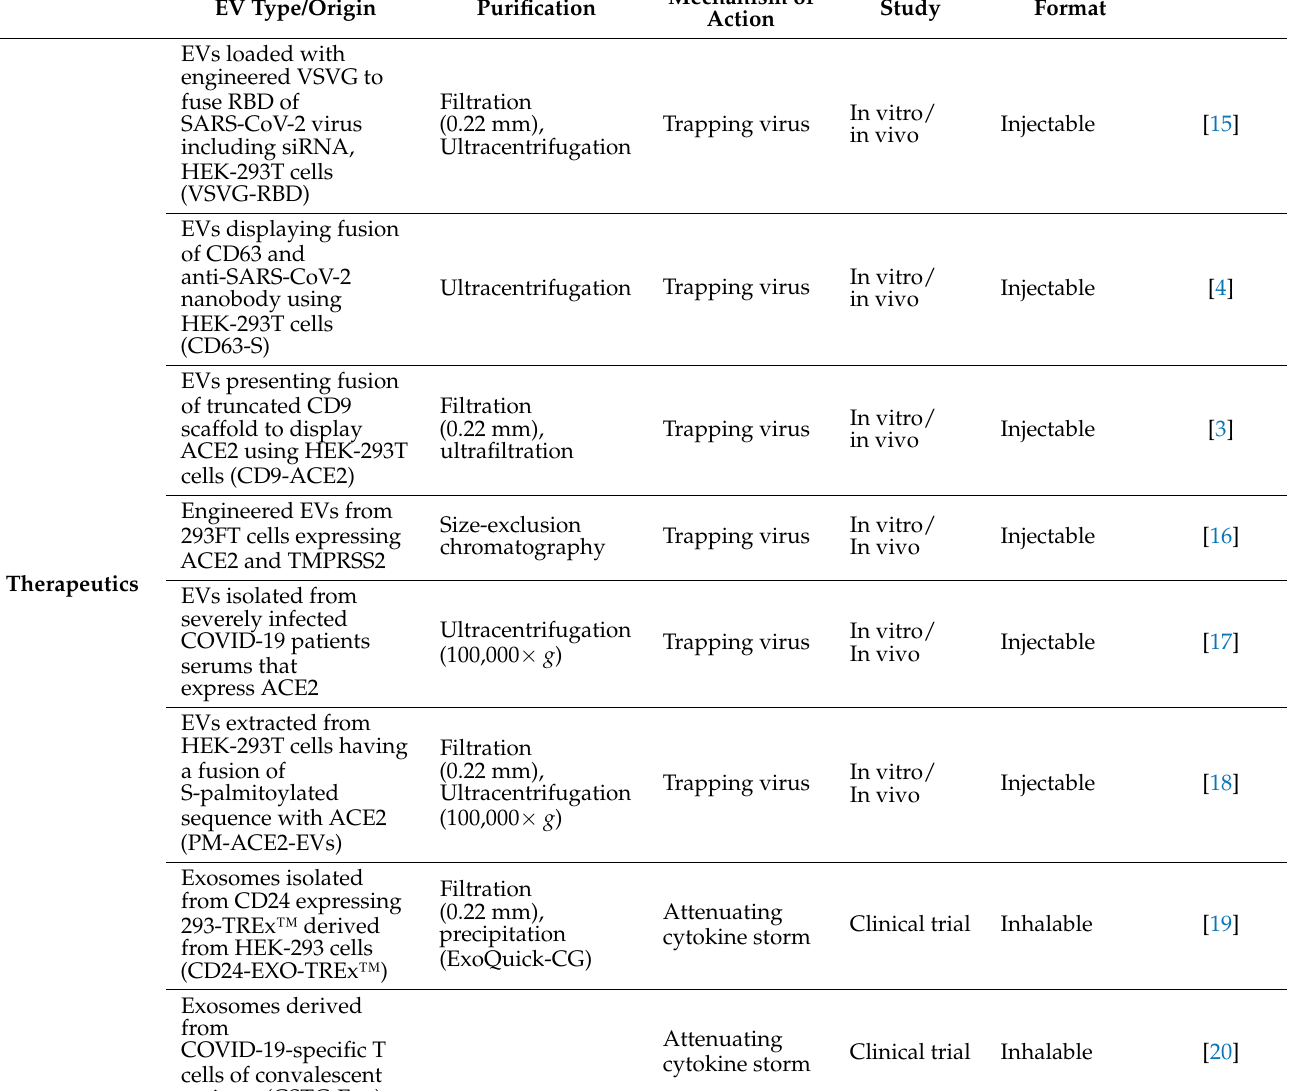
Table 1. EV-based therapeutics and vaccine candidates under development for